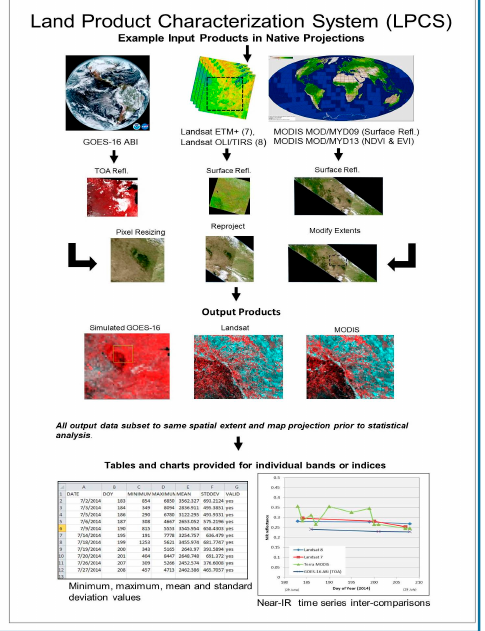
Figure 1. Example of general functionality within the Land Product Characterization System (LPCS) (https://landsat.usgs.gov/lpcs).